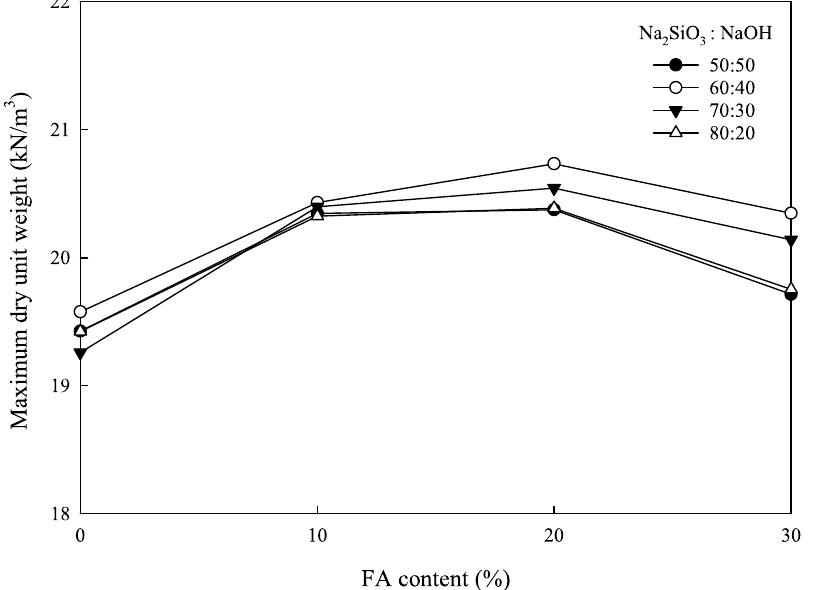
Figure 2. The relationship between FA content and maximum dry unit weight of RCA-FAG sam- ples.